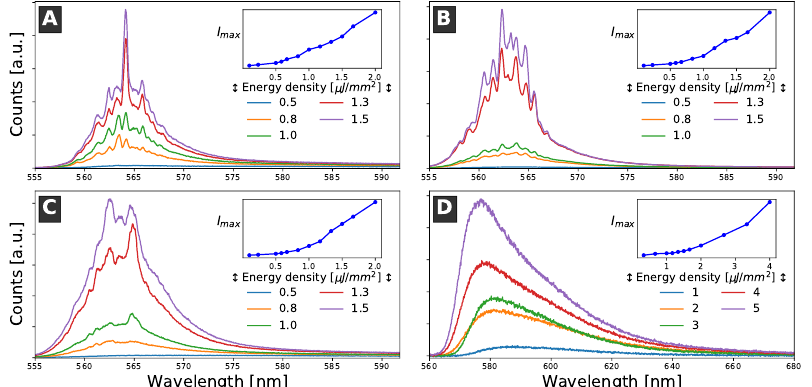
Figure 4. Evolution of the emission of the sample with increases in the pumping power density. The blueshift of the spectra, the emergence of narrow (FWHM < 1 nm) lines, and the dramatic increase in emission intensity were all due to the coherent RL. ( A ) NT (non-transfected N2A cells). ( B ) HTT-Q23 (N2A cells transfected with the non-pathogenic pEGFP-Q23). ( C ) HTT-Q74 (N2A transfected with the pathogenic pEGFP-Q74). ( D ) Petri dish without cells. In this case, an ASE, but not RL, was